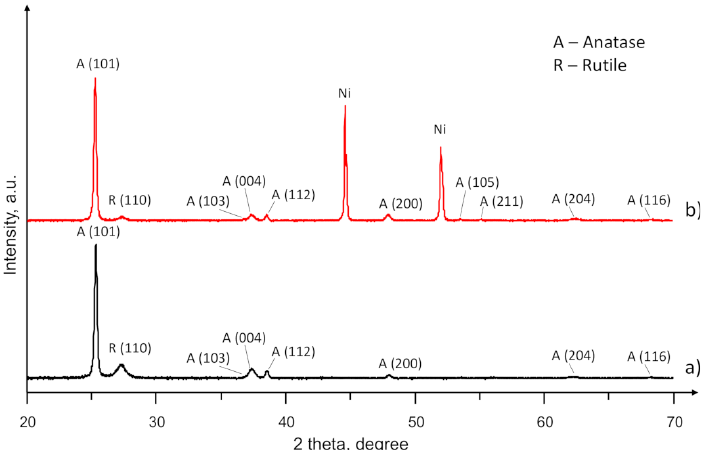
Fig. 3. XRD patterns of as deposited films: a) carbon-doped TiO 2 film deposited directly on borosilicate glass substrate; b) carbon-doped TiO 2 film deposited on Ni underlayer. Rietveld refinement revealed that Ni underlayer effect for the crystallite size of anatase and rutile phases is not significant, but its effect on phase ratio is more pronounced (Table